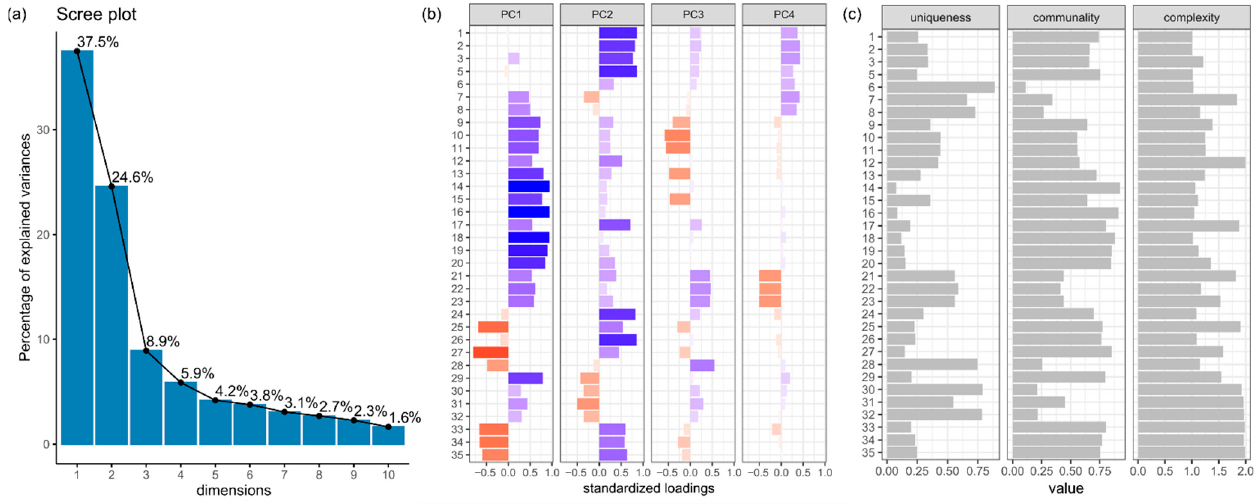
Figure 6. ( a ) The scree plot; ( b ) The structure of the first four PCs. Colours correspond to the value of standardized loading; ( c ) The statistics for the first two PCs. Numbers (1–35) correspond to the names of the variables (see Appendix C, Table A1).